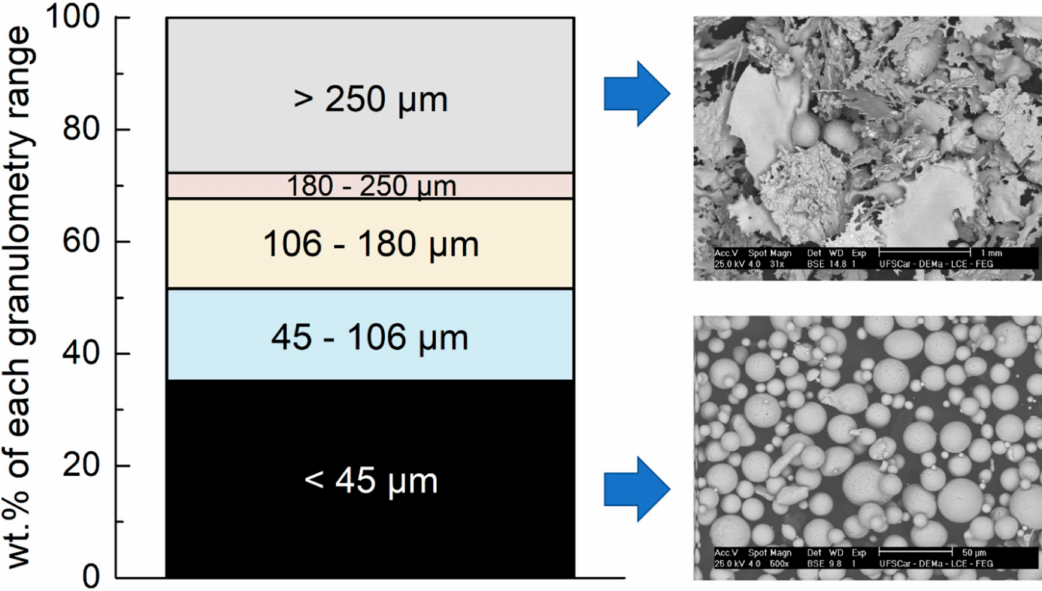
Figure 6. Weight percentage of powders with different particles size ranges from the gas atomization process. Backscattered electron images indicate the different morphologies from spherical-like to plate-like shapes depending on the particle size